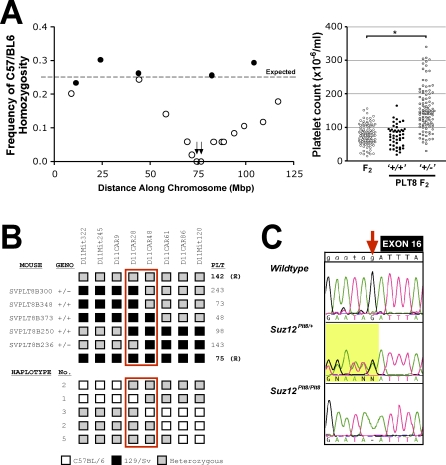
Genetic Mapping and Identification of the Plt8 Mutation(A) 90 PLT8 F2 mice were genotyped with polymorphic microsatellite markers spread throughout the genome. The frequency of C57BL/6 homozygosity is plotted along the length of Chromosome 10 (filled circles) and Chromosome 11 (open circles). No mice were homozygous C57BL/6 across an interval on Chromosome 11 (arrows). PLT8 F2 mice that carried C57BL/6 DNA (‘+/–') at this position had a higher mean platelet count than wildtype mice (a control F2 population, *p < 0.002) or littermates that were homozygous 129/Sv (‘+/+').(B) A 1.39-Mb candidate interval was defined between D11CAR28 and D11CAR48 (boxed in red). Genotyping is shown for individual recombinants (top panel); C57BL/6 homozygosity is represented by open boxes, heterozygous markers are gray and 129/Sv homozygosity is shown in black. A haplotype map is shown (bottom panel) that defines the same interval using the lethality phenotype; the number of mice with each haplotype is shown at left.(C) DNA was extracted from PLT8 mice with elevated platelet counts for sequence analysis. A single base pair deletion was identified in heterozygous mice (Suz12Plt8/+) and in homozygous tissue obtained from embryos (Suz12Plt8/Plt8) (red arrow). The deletion disrupts the splice acceptor site upstream of exon 16.